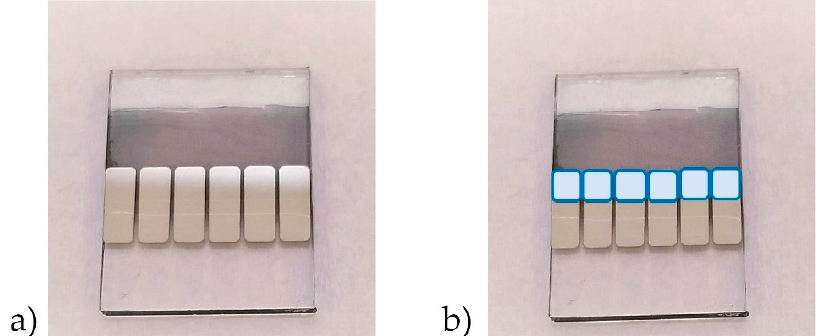
Figure 16. ( a ) Complete fabricated bulk heterojunction organic solar cells (BHJ OSC). The silver area is the Ag cathode. The pattern is created with the mask utilized during Ag deposition via vacuum thermal evaporation (VTE). ( b ) The blue squares superimposed onto the photograph indicate the active area of the device.